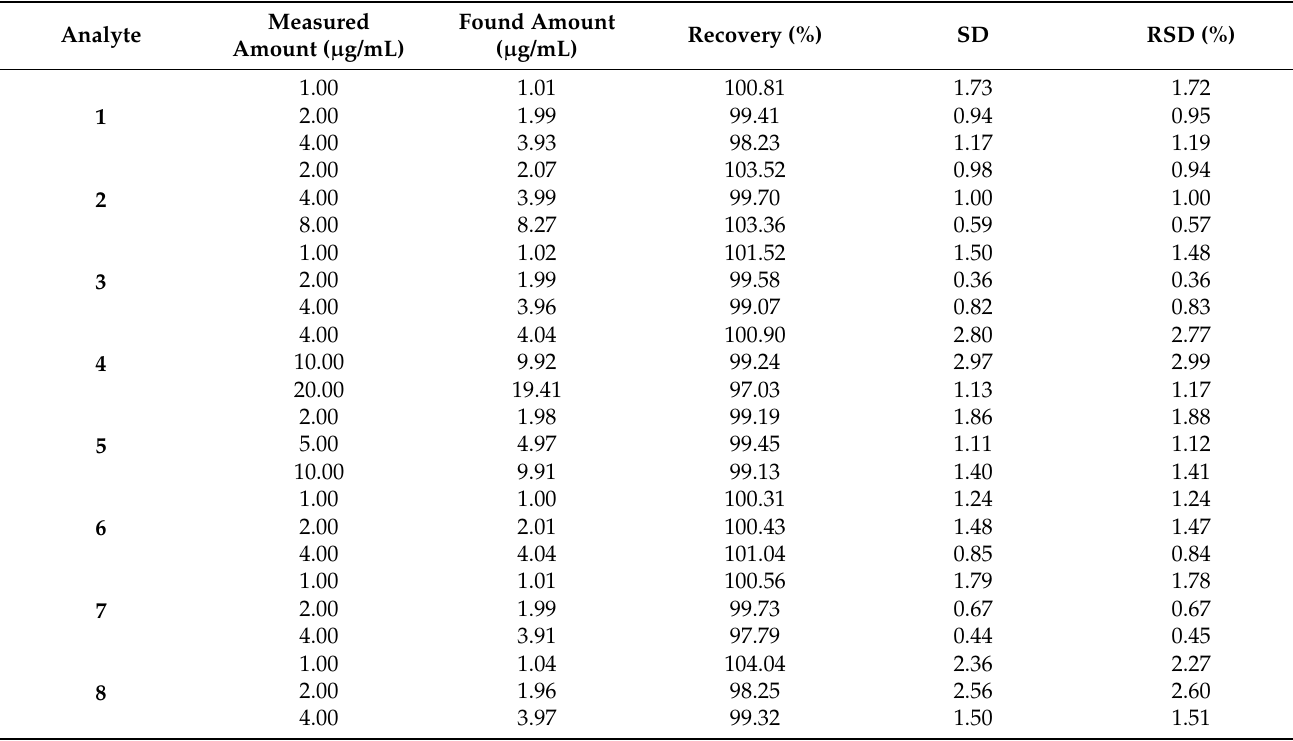
Table 2. Extract recovery test of compounds 1 – 18 in the developed analytical